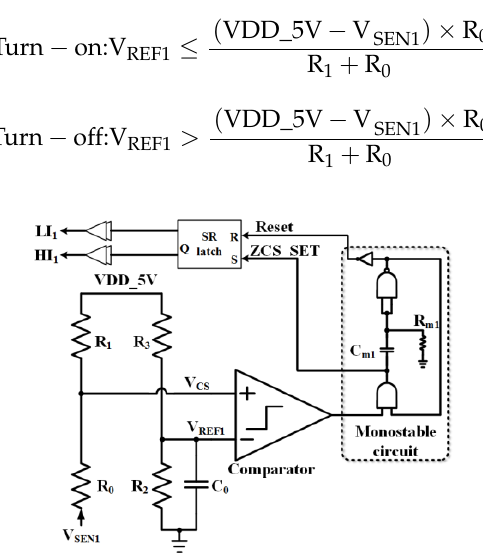
Figure 3. Zero current sensing (ZCS) circuit for M HS1 and M LS1 .